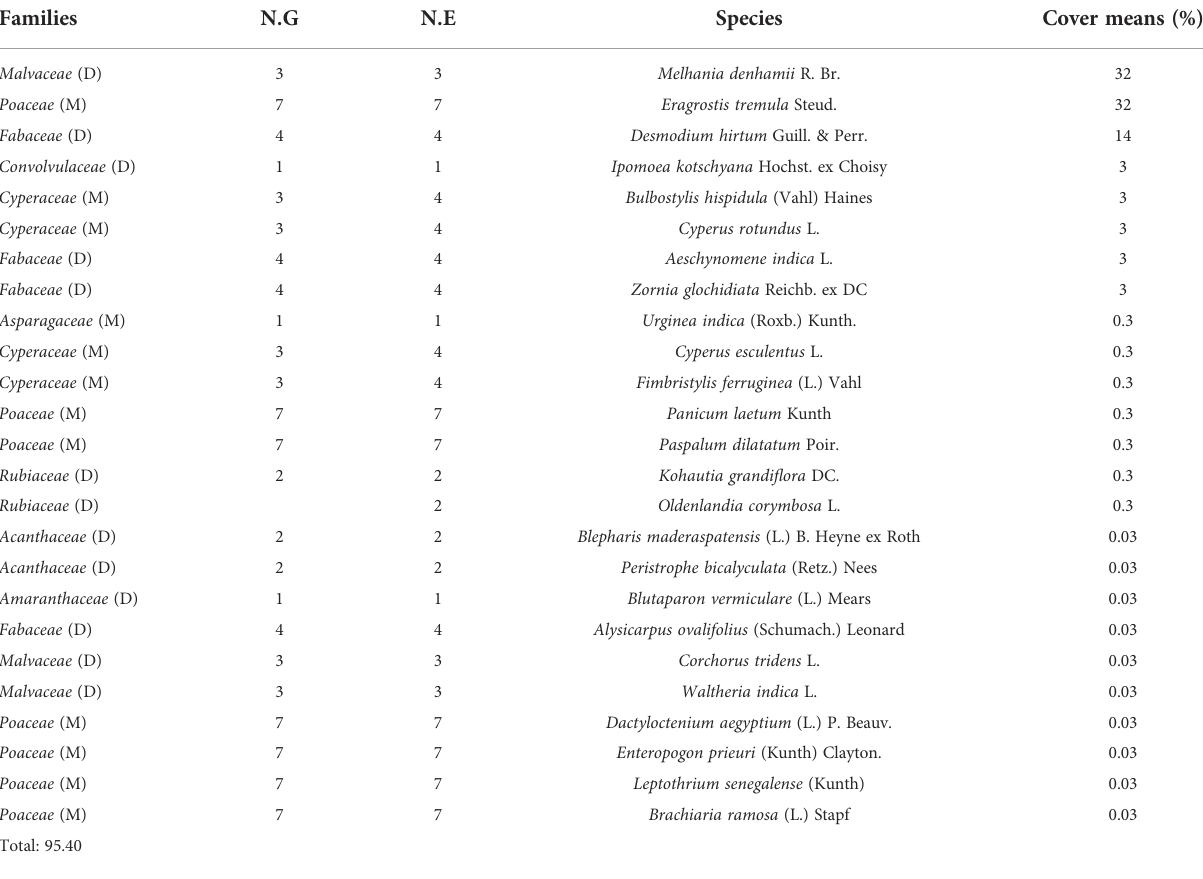
TABLE 6 Percentages of the coverage of herbaceous species beneath Vachellia seyal.